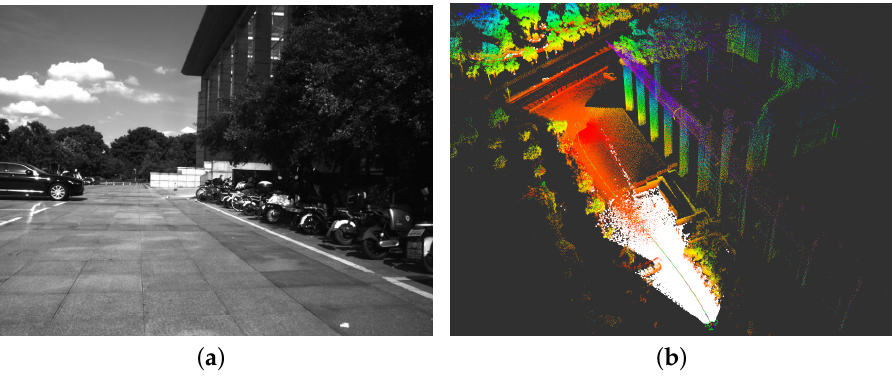
Figure 5. ( a ) The visual image view. ( b ) The ground point clouds(white) detected by our LiDAR inertial subsystem. It’s clear that the ground point clouds can be segmented